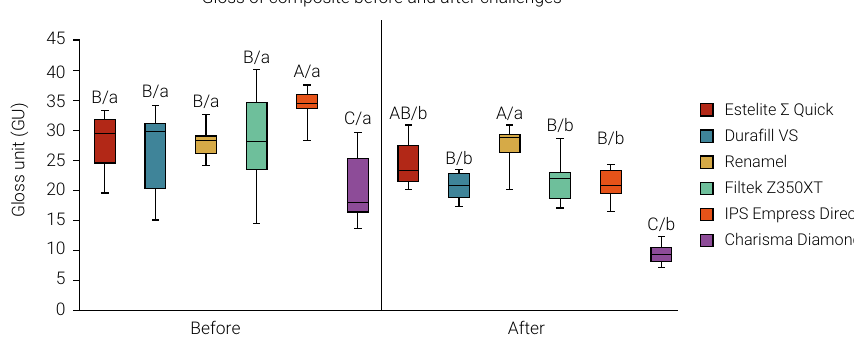
Figure 3. Box plots of gloss (GU unit) of resin composites before and after challenges. Different uppercase letters represent statistical significance among composites (p<0.05). Different lowercase letters indicate statistical significance before and after challenges